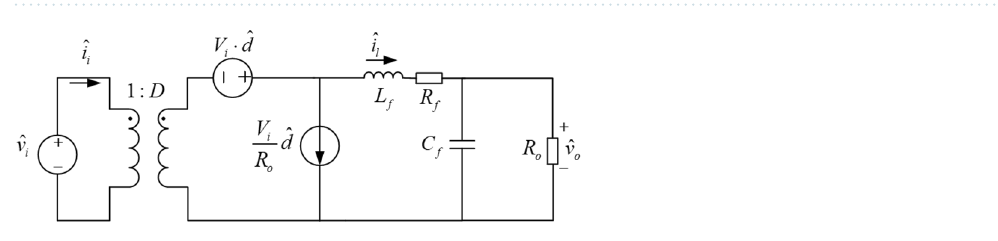
Figure 4. AC small-signal model of PSFB DC–DC